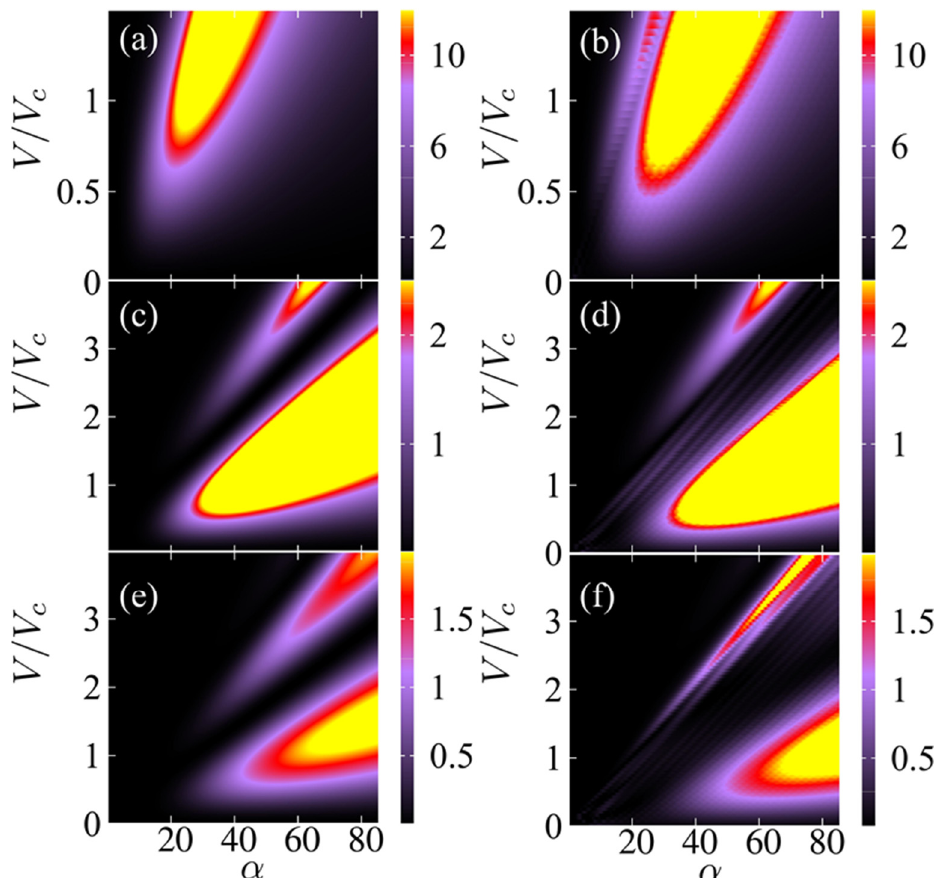
Figure 5. ( a , b ) Second, ( c , d ) fourth and ( e , f ) sixth harmonics output powers (arb. units) in a superlattice with period d , for δ = 1 ( a , c , e ) and δ = 1.3 ( b , d , f ), as a function of α = ( eE i ) d / ( h ν ) , V (voltage) and δ (asymmetry parameter). The input electromagnetic field oscillates at ν = 249 GHz. The control voltage, V / V c is given as a ratio with respect to the critical voltage V c , which characterizes negative differential resistance.